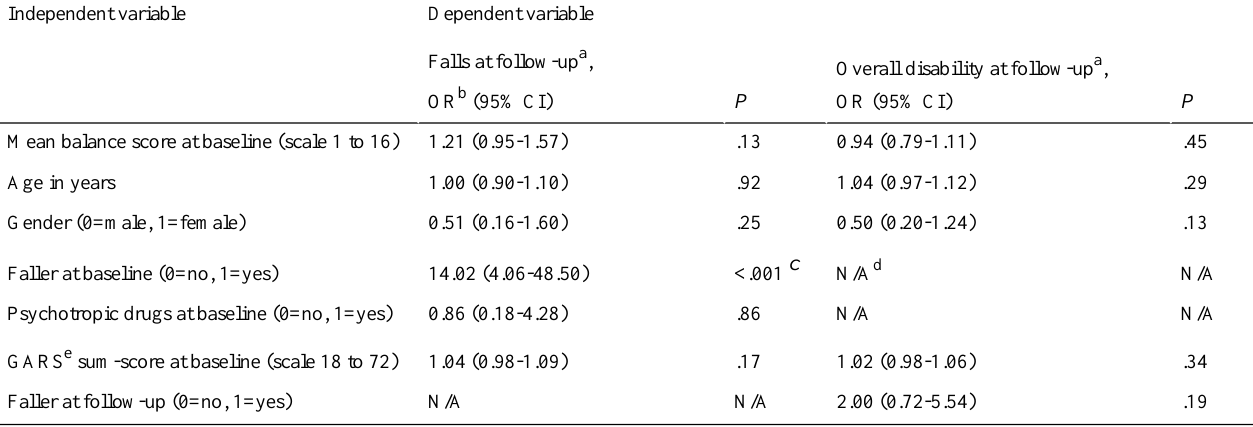
Table 3. Multivariate predictors of falls and disability development after 6 months of follow-up